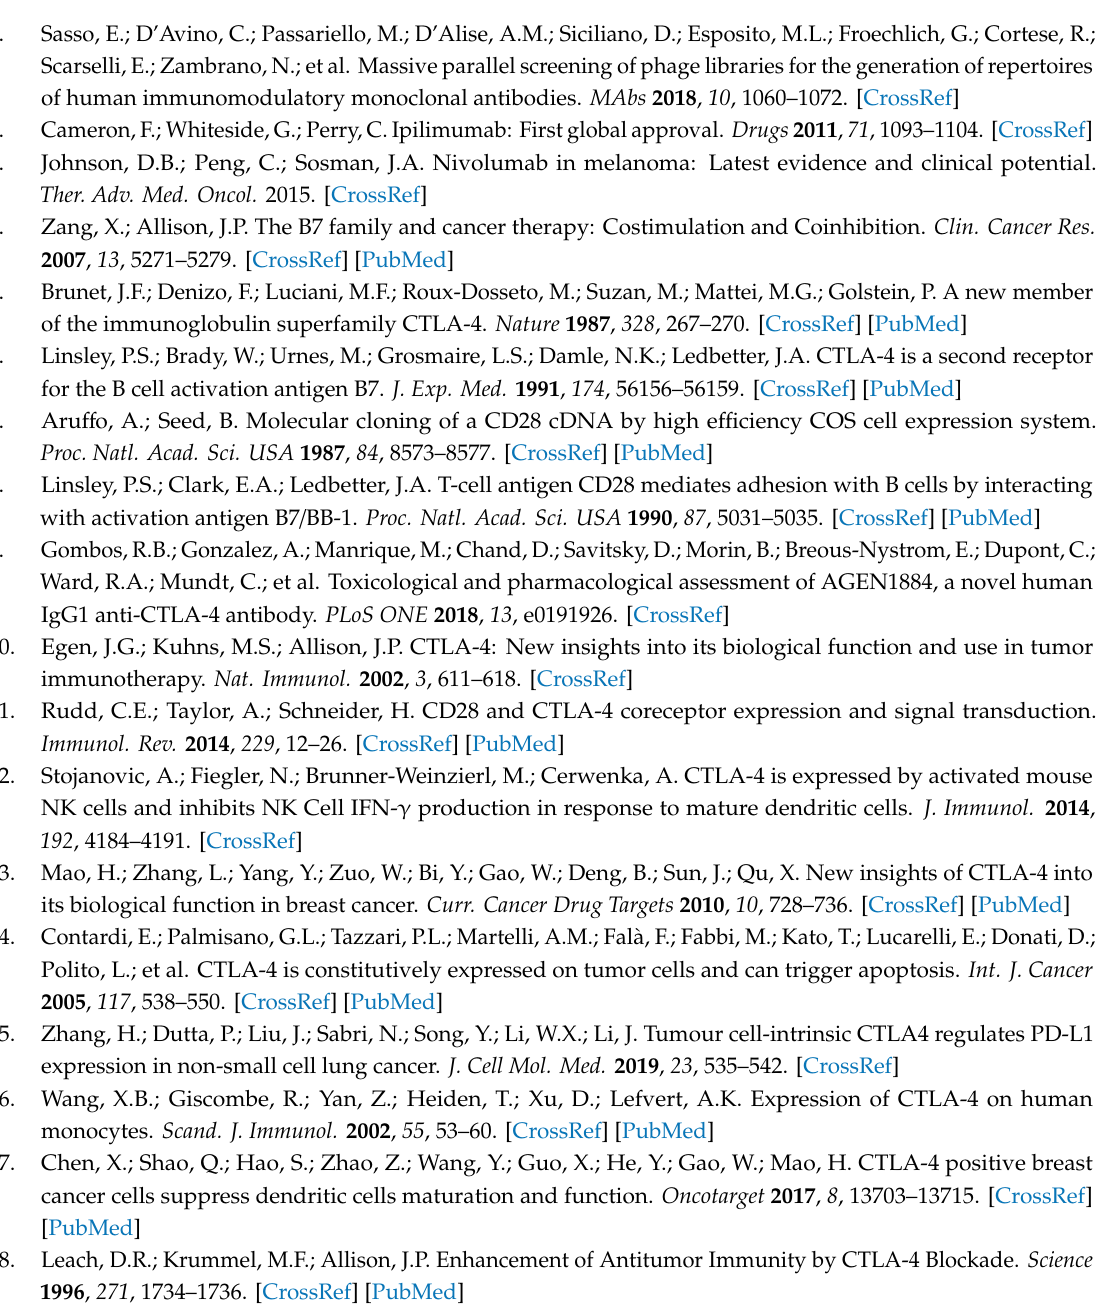
Figure S1: Full length blot of Figure 1B, Figure S2: E ff ects of CL4 aptamer and Ipilimumab mAb on tumor cell intracellular